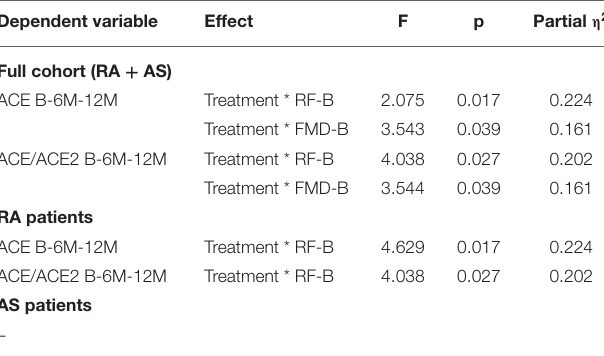
TABLE 3 | Significant results of general linear model (GLM) repeated measures analysis of variance (RM-ANOVA) test determining the effects of treatment and other independent variables on ACE and ACE2 as dependent